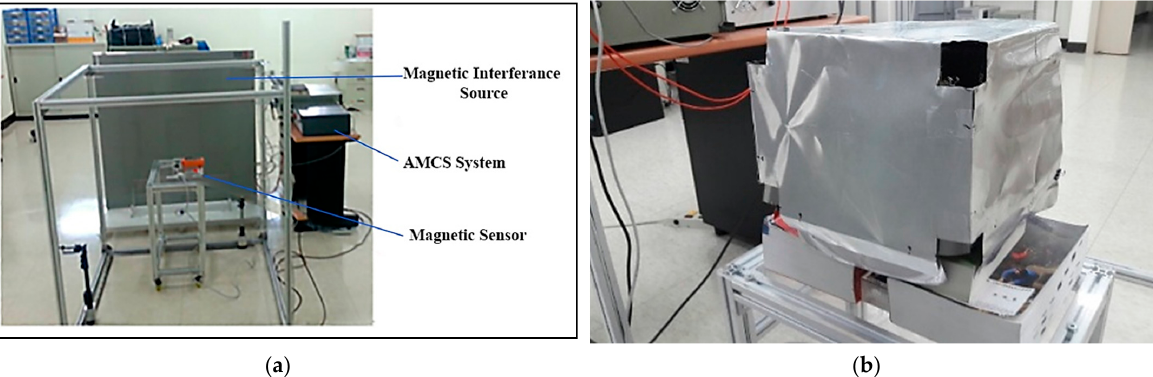
Figure 10. The experiment settings of the MFCS: ( a ) the setting of the AMCS and ( b ) the shielding box with holes at four corners. box with holes at four corners.